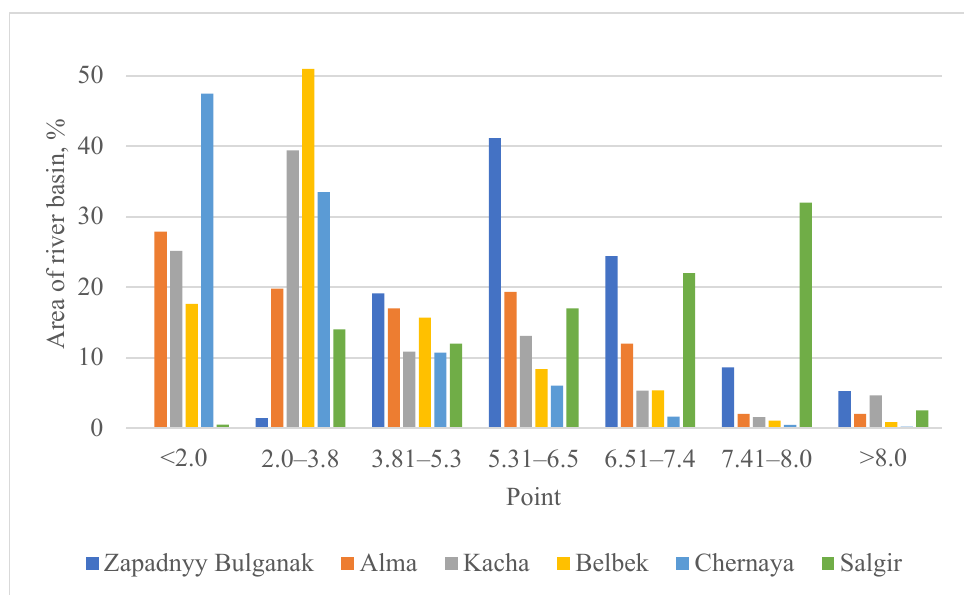
Figure 4. Distribution of the anthropogenic transformation coefficient in the basins of the Zapadnyy Bulganak, Alma, Kacha, Belbek, Chernaya, and Salgir rivers.